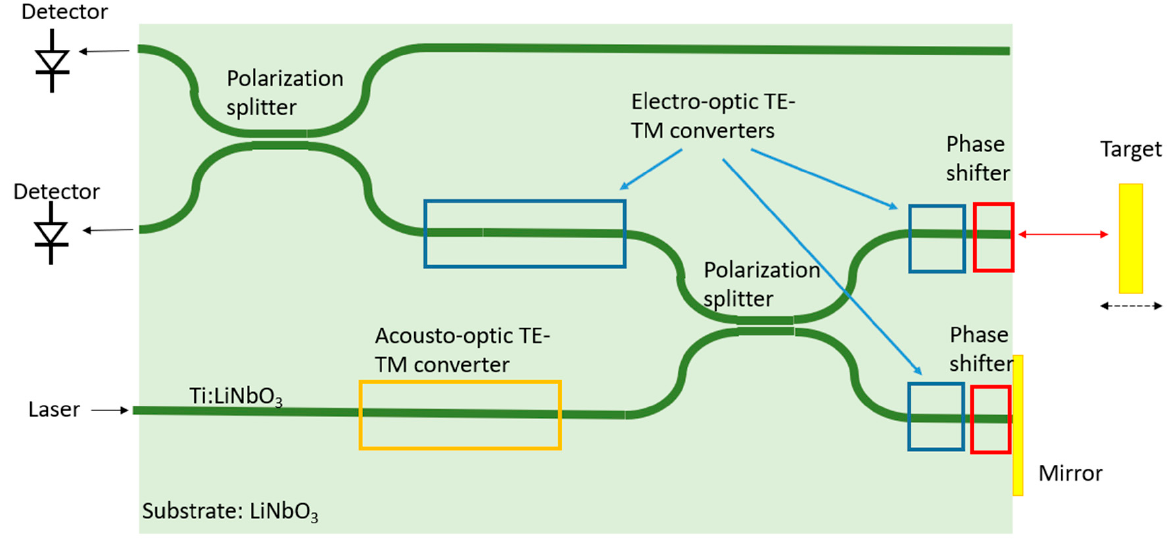
Figure 9. Schematic of the integrated optical heterodyne interferometer in Ref. [46].